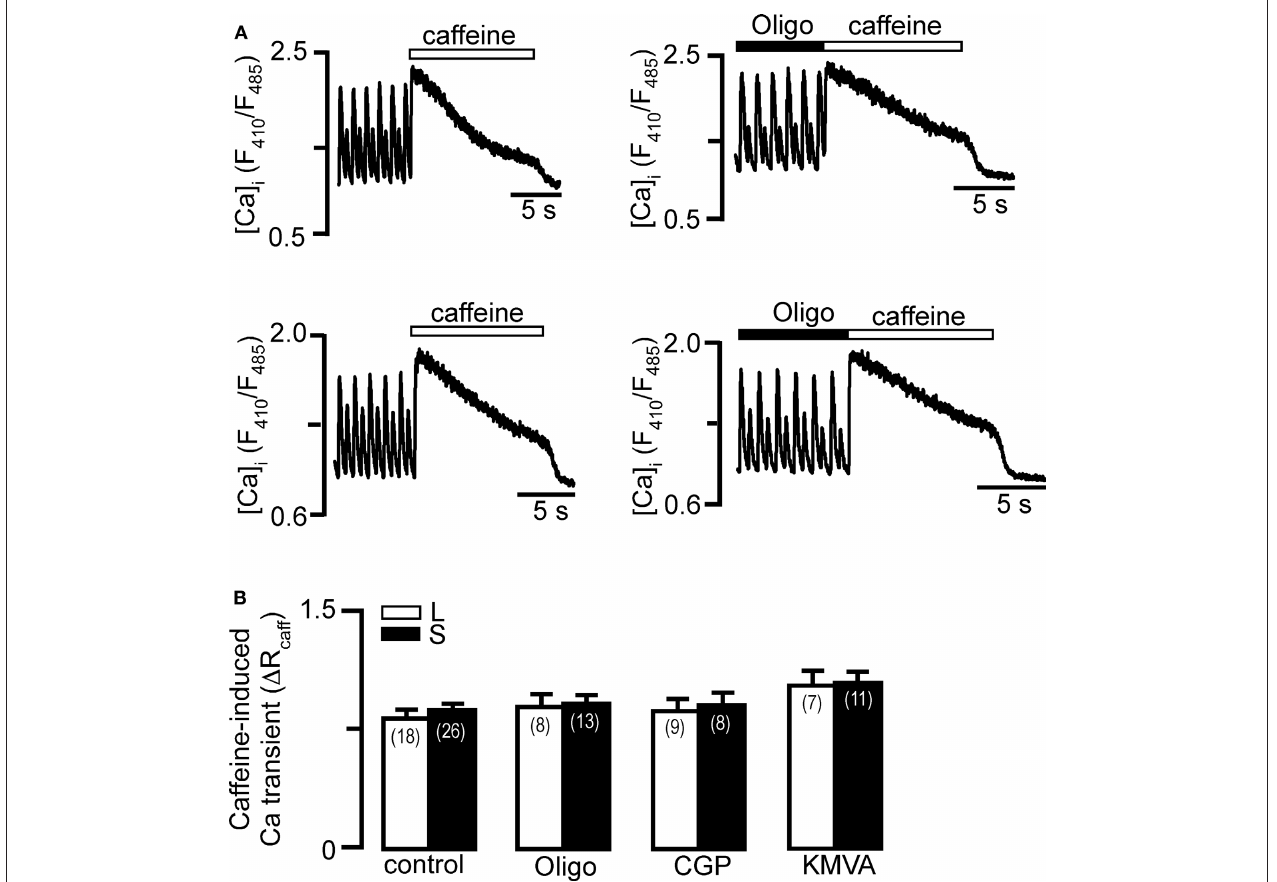
load during Ca alternans after large and small amplitude Ca transient in control, and in the presence of oligomycin, CGP-37157 (CGP, 2.5 μM) and KMVA (5 mM). SR Ca load is quantified as the amplitude of the caffeine induced Ca transient where ∆ R = R . Numbers in parentheses indicate the number of − R peak diastole individual cells